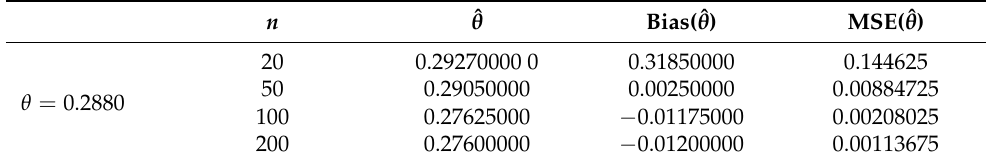
Table 1. Estimation for θ corresponding to weak dependence. n ˆ θ Bias(ˆ θ ) MSE(ˆ θ )